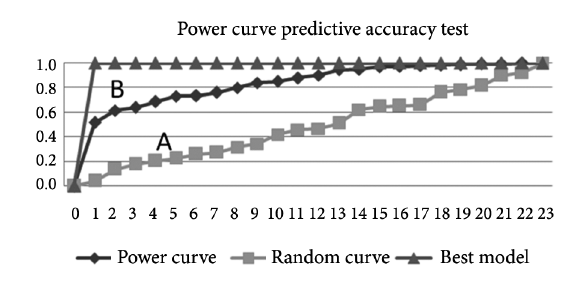
Figure 1. Accurate ratio (source: own